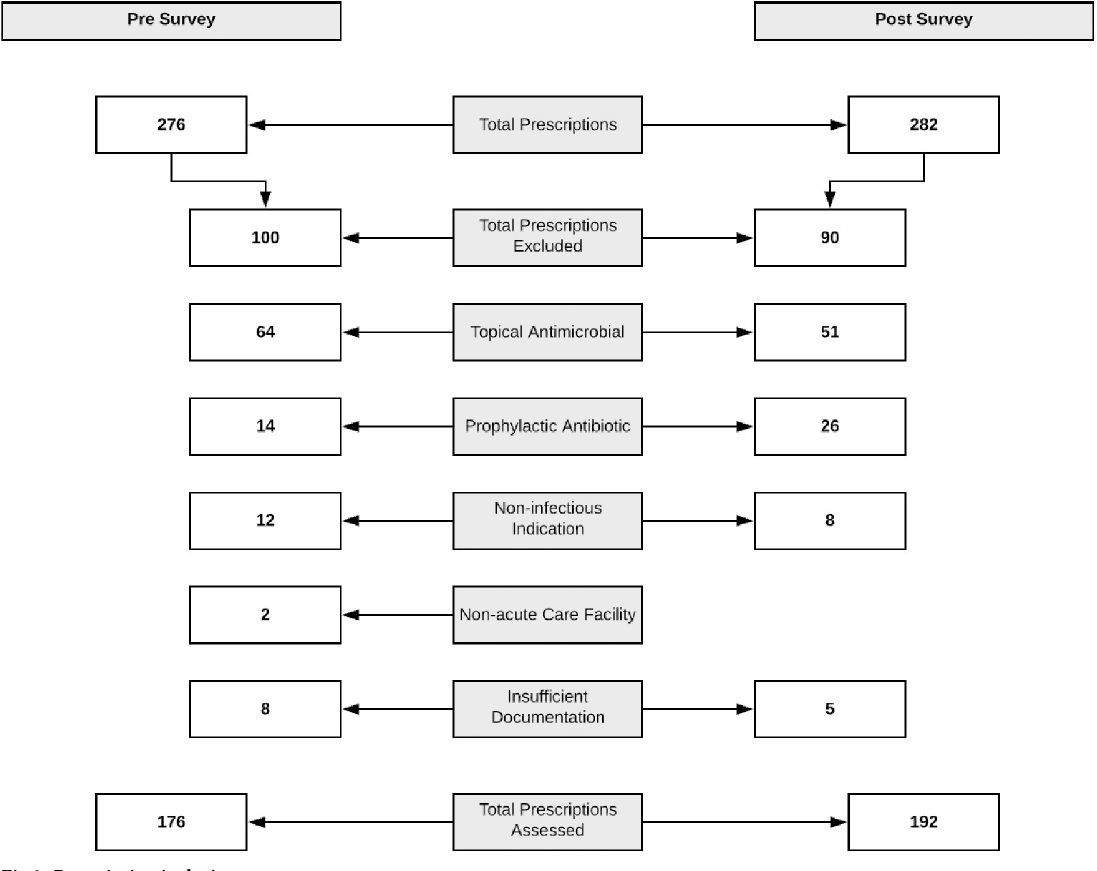
Fig 2. Prescription inclusion.